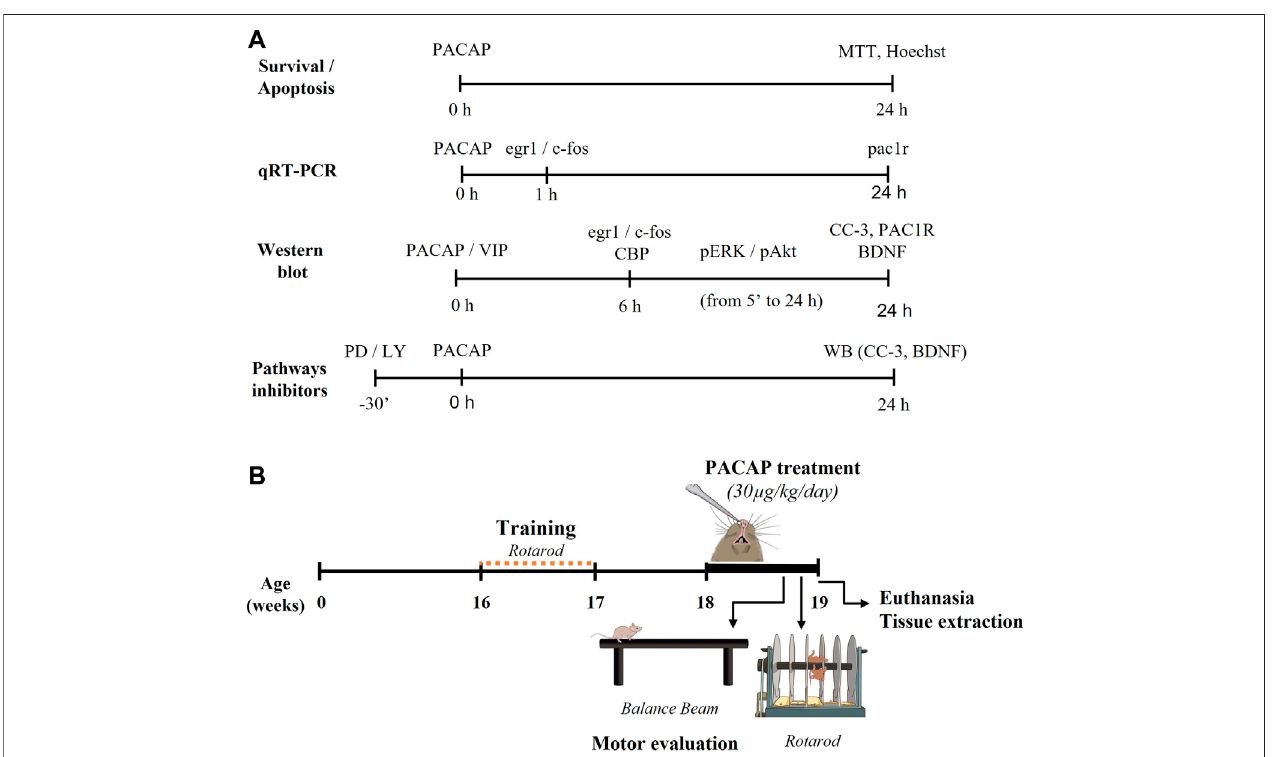
FIGURE 1 | Experimental design of the study. (A) Methodology performed to determine cell viability and molecular changes in STHdh cells after the pharmacological treatments. STHdhQ7/Q7 and STHdhQ111/Q111 cells were treated with PBS as vehicle, PACAP (10 – 7 M) and/or VIP (10 – 7 M) for the appropriate number ofhours.Then, westudied cellviabilitybyMTT assayand Hoechst stain,thegeneexpression byqRT-PCR,and theprotein levels byWestern blotting. Toinhibit ERK and PI3K-Akt pathways, cells were exposed to PD98059 (25 µM) or LY294002 (10 µM), respectively, for 30 min before PACAP treatment. (B) Methodology performed to study the capacity of PACAP to improve the motor de fi cits of R6/1 HD mouse model. At the age of 18 weeks, mice were daily treated intranasally with PACAP (30 μ g/kg/day) for 7 days. Motor function was evaluated after 5 days of treatment by the Balance Beam test and after 6 days by Rotarod test. At the 7th day of treatment, animals were sacri fi ced by cervical dislocation and the striatum was rapidly dissected out.